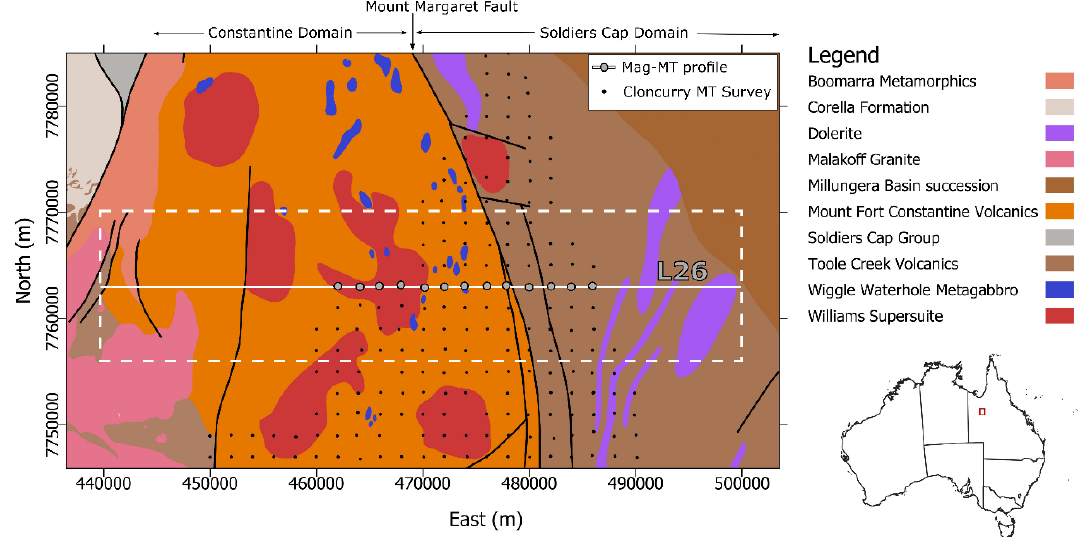
Figure 8. Interpreted solid geological map of the area (Dhnaram and Greenwood, 2013). The small dots are the MT sites of the Cloncurry MT survey. The red line is the profile used in this study, and the red dots are the MT sites associated to this profile. The Constantine domain to the west and the Soldiers Cap domain to the east are separated by the Mount Margaret fault. The dashed red line delineates the area we focus